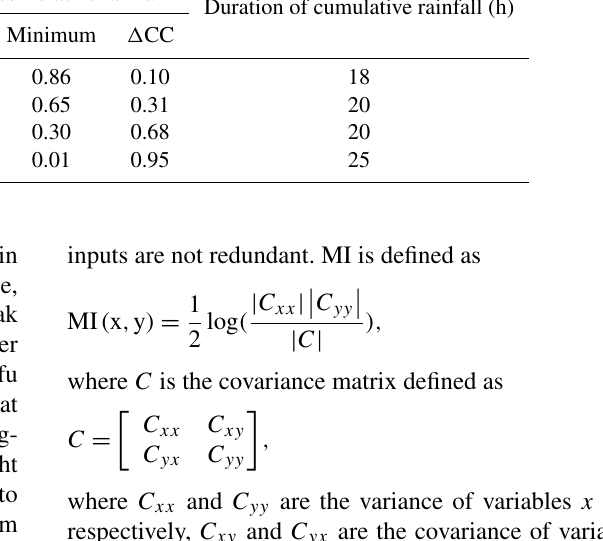
Table 3. Correlation coefficient (CC) between water-level and cumulative rainfall with average peak and the associated duration of cumulative rainfall. CC between water-level and cumulative rainfall Gauging site Average peak